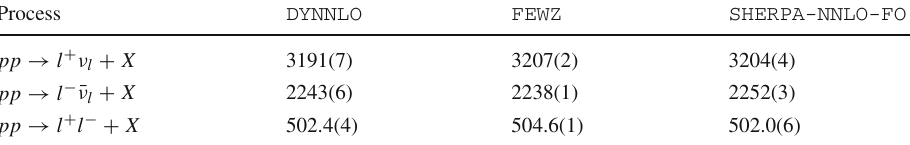
Table 12 Tuned comparison of NNLO QCD total cross sections (in pb) at the 8 TeV LHC in the benchmark setup with ATLAS/CMS